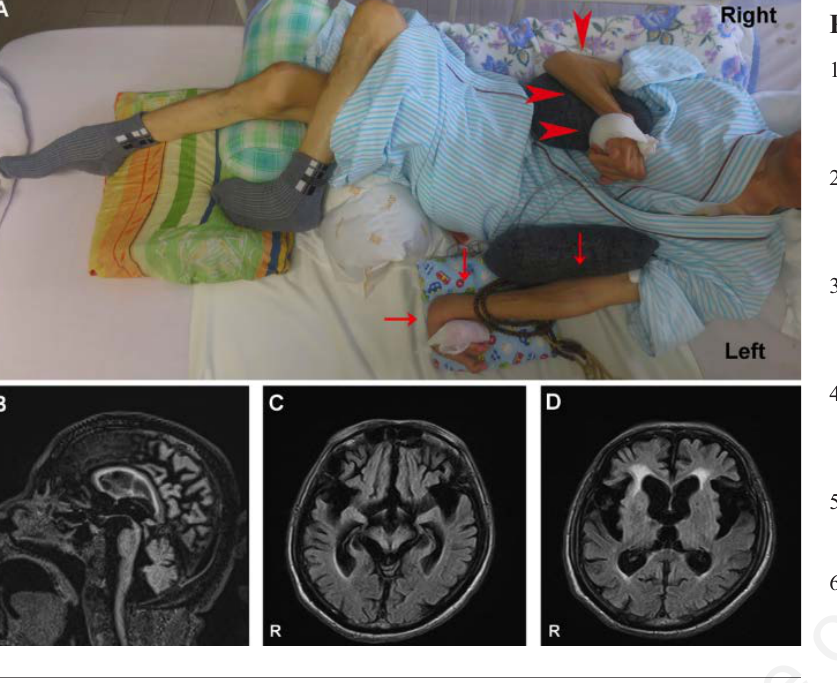
Figure 1. A) Alternating flexed–extended posture in the upper limbs; flexed right arm (arrowheads) and extended left arm (arrows). B-D) Fluid-attenuated inversion recovery (FLAIR) MRI with diffuse atrophy in the midbrain and cerebral